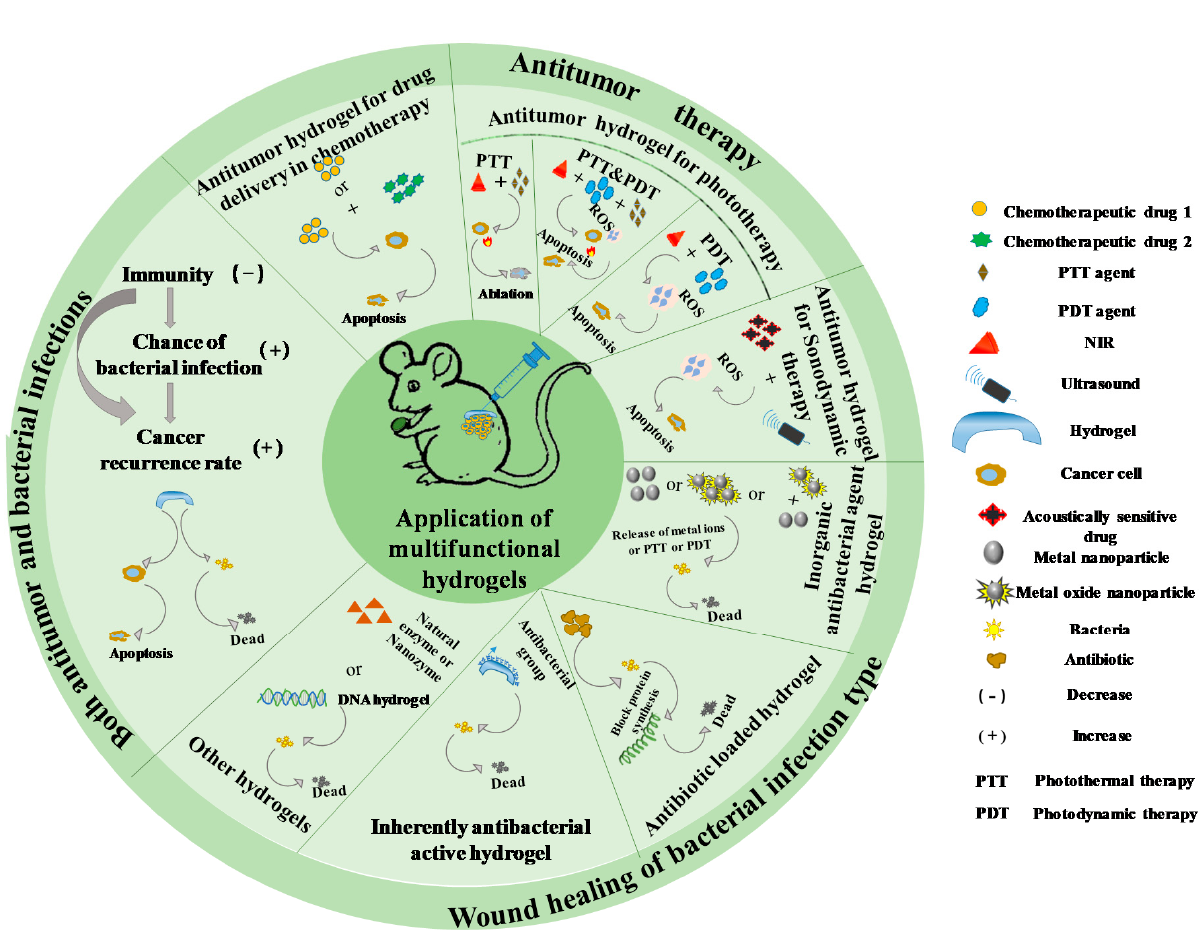
Figure 1. Schematic diagram of the application of multifunctional hydrogels. Table 1. The classification of hydrogel functional components.